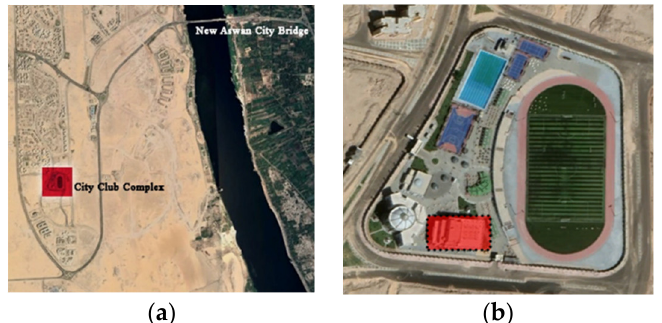
Figure 1. The investigated building location: ( a ) the location of the city club complex in relation to New Aswan city; ( b ) the intended building on the planned site of the city club complex.